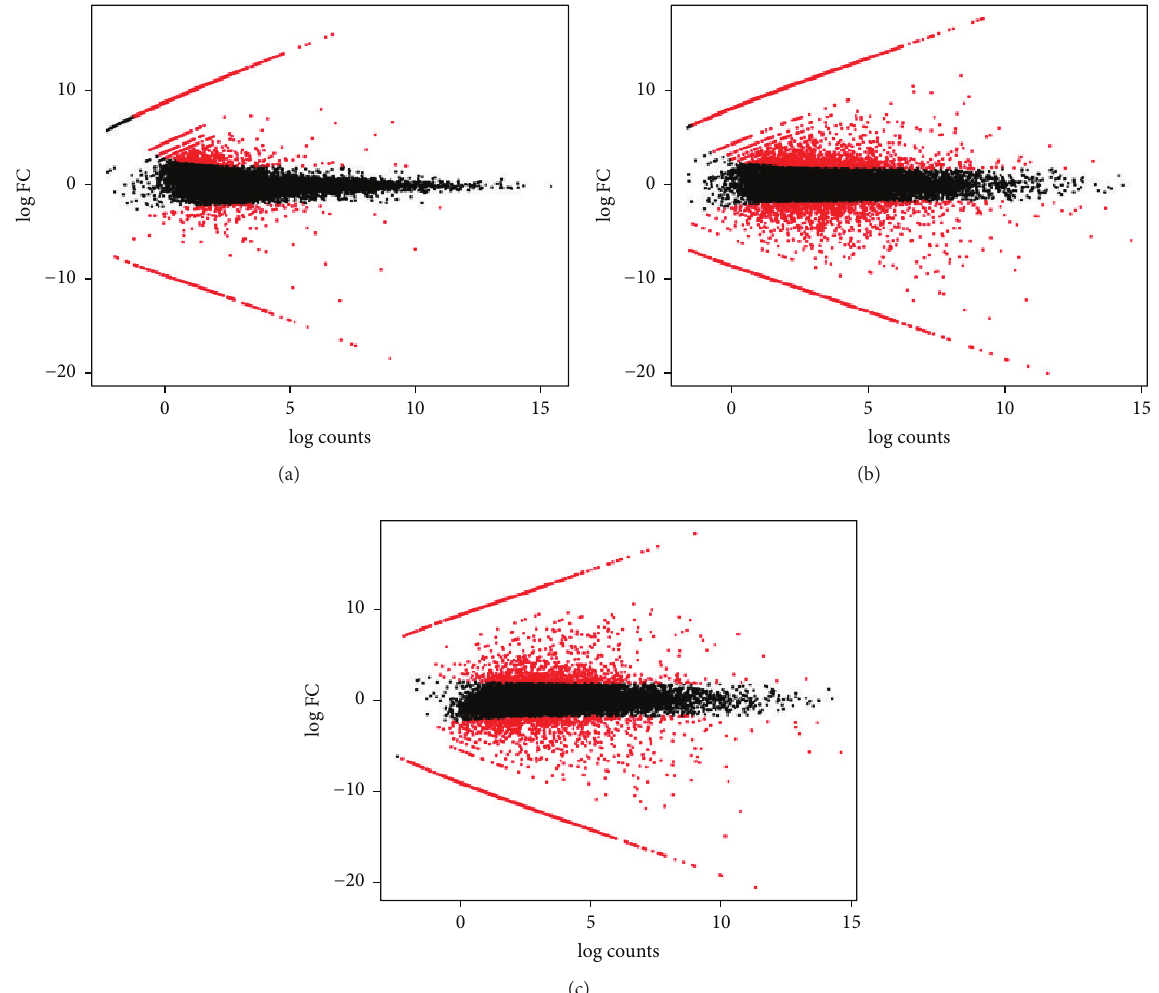
Figure 1: Pairwise comparisons of transcript abundance from self-pollination in self-sterile cultivar versus cross-pollinated sample (a), from self-pollination in self-fertile cultivar versus cross-pollinated sample (b), and in between self-pollination in self-sterile cultivar and self- pollination in self-fertile cultivars (c). 𝑀𝐴 plot for DE analysis by EdgeR: for each gene, the log 2 (fold change) (log 2 (sample (a)/sample (b))) between the two samples is plotted ( 𝐴 , 𝑦 -axis) against the gene’s log 2 (average expression) in the two samples ( 𝑀 , 𝑥